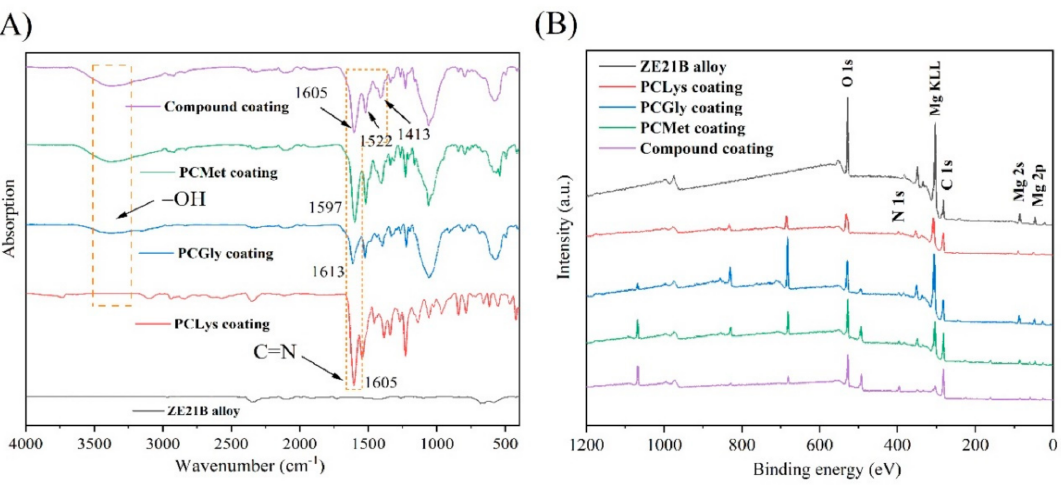
Figure 3. ( A ) FT-IR spectrum and ( B ) XPS full spectrum of PCLys-, PCGly-, PCMet-, and compound Schiff base-coated ZE21B samples, and the bare